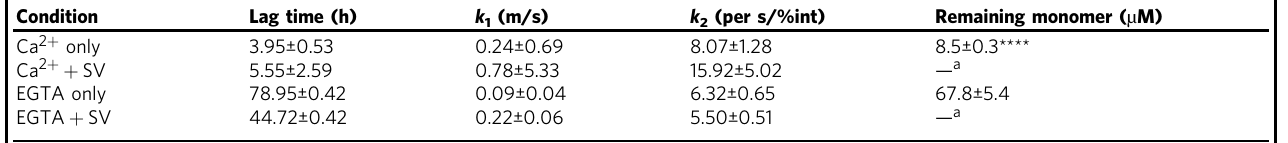
ThT fl uorescenceintensitypro fi leswereusedtocalculatethelagtimeaswellasthenucleation( k 1 )andtheelongationrate( k 2 ).Lagtimeisgivenas X interceptwithstandarderror. k 1 and k 2 aregivenas constants with a 95% con fi dence interval. Three biological repeats. Remaining alpha-synuclein monomer concentration was revealed by analytical SEC-HPLC at the end of the experiment **** p <0.0001, n = 10 for Ca 2 + only, and n = 9 for EGTA only, where n indicates wells, two biological repeats, calculated using two-tailed t -test, values indicate mean ±s.e.m. d.f.